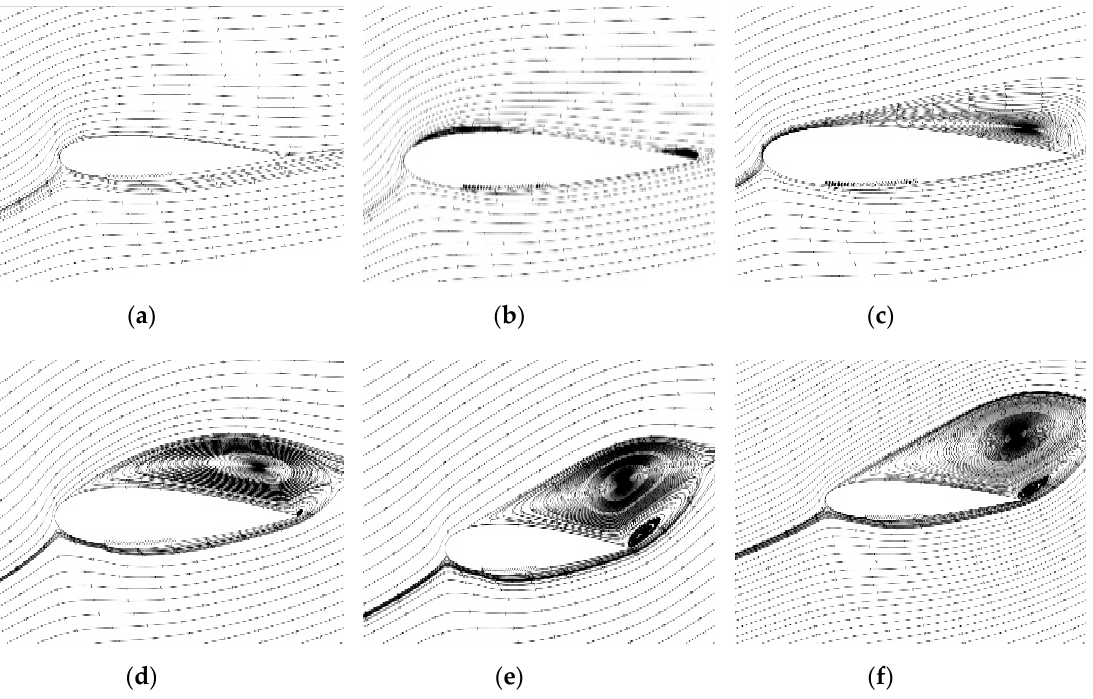
Figure 22. Streamline of standard NACA0012 airfoil at a 14° angle of attack at different times. ( a ) t = 0.001 s, ( b ) t = 0.01 s, ( c ) t = 0.02 s, ( d ) t = 0.03 s, ( e ) t = 0.04 s, ( f ) t = 0.05 s, ( g ) t = 0.06 s, ( h ) t = 0.07 s, ( i ) t = 0.09 s, ( j ) t = 0.11 s, ( k ) t = 0.13 s, and ( l ) t = 0.15 s.